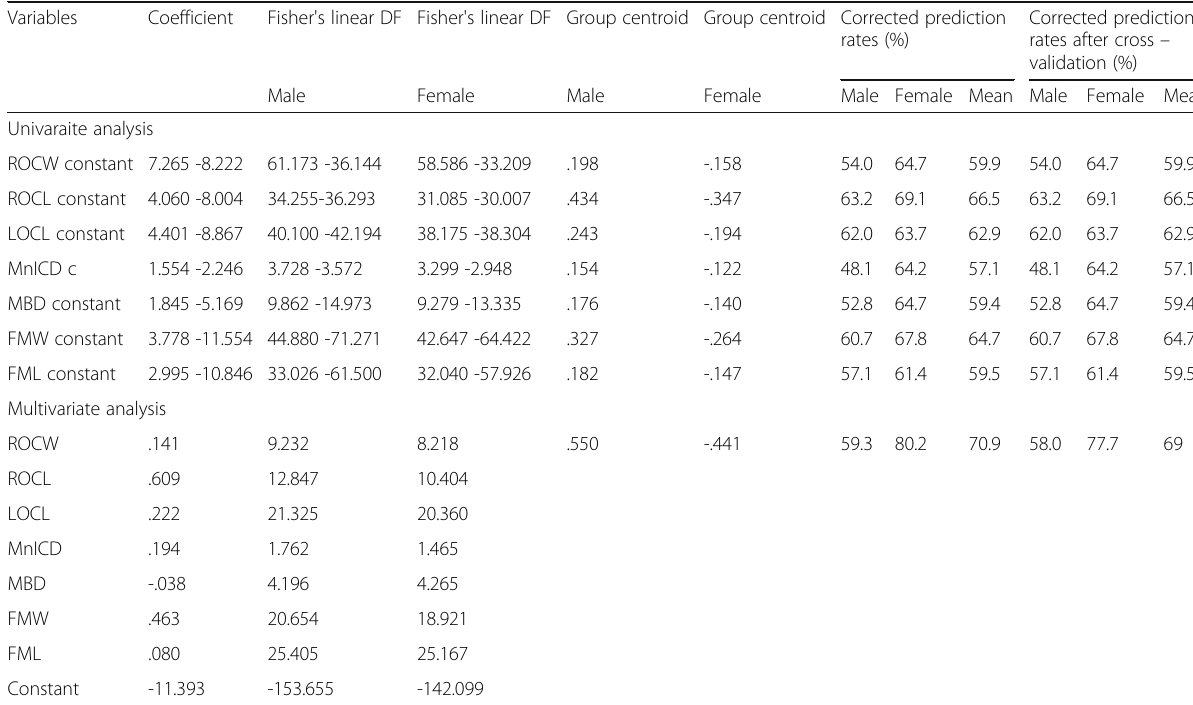
DF : Discriminate function, ROCW : Right occipital condylar width, ROCL : Right occipital condylar length, LOCL : Left occipital condylar length, MnICD : Minimum intercondylar distance, MBD : Maximum intercondylar distance, FMW : Foramen magnum width, FML : Foramen magnum